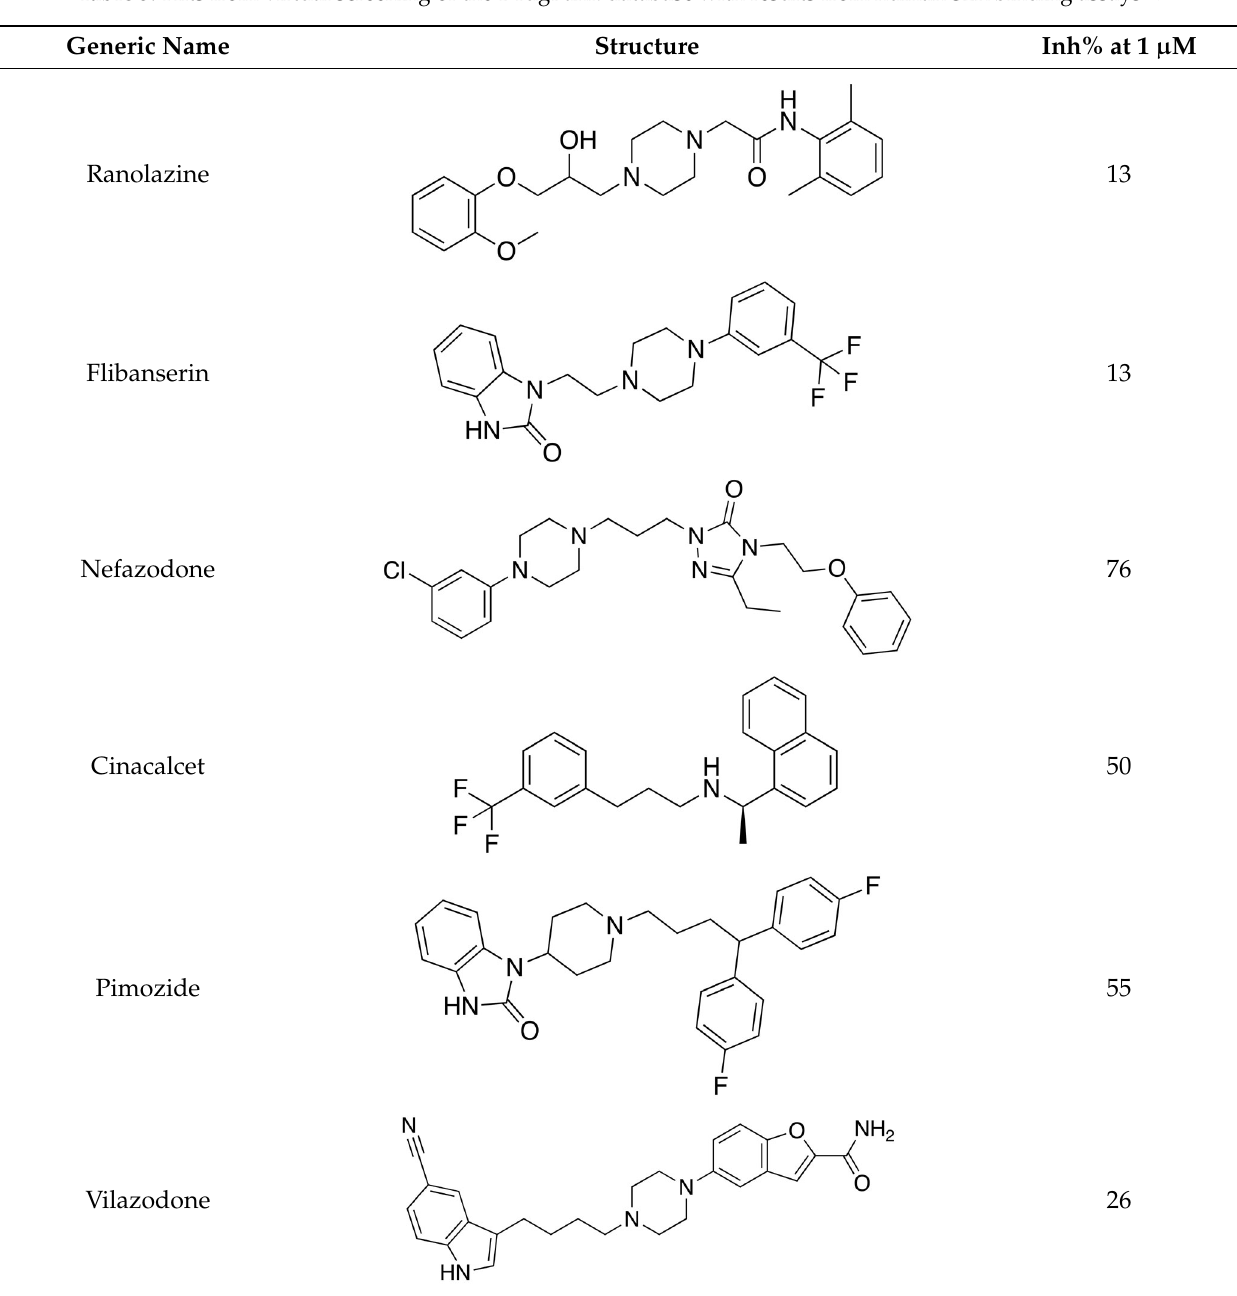
Table 5. Hits from virtual screening of the DrugBank database with results from human S2R binding assays